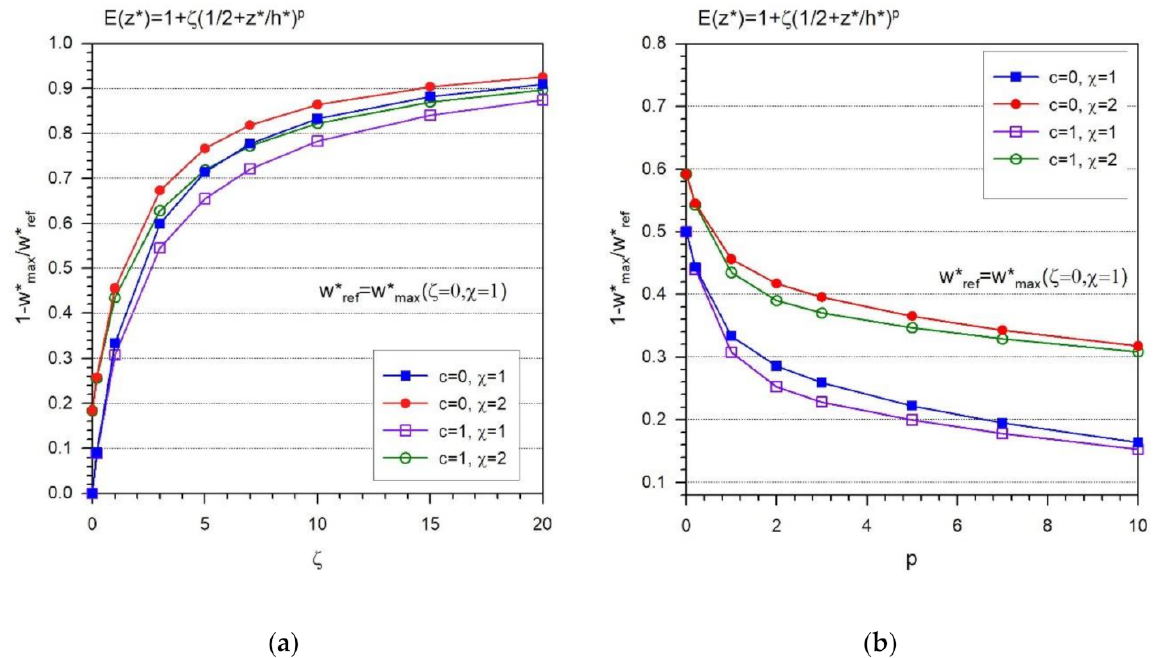
Figure 7. Dependence of the reduction of maximal deflections on ( a ) parameter ζ and ( b ) on exponent p